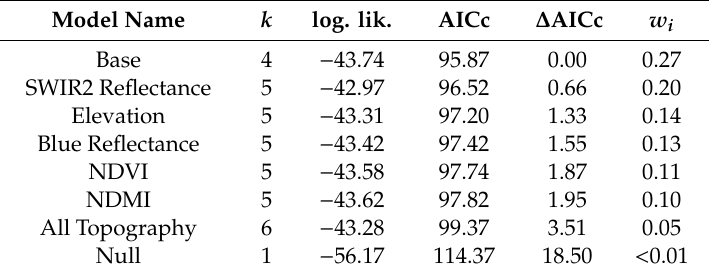
Table 4. Ranking of candidate models used to predict lichen presence as a function of forest structure, topographic and remote sensing attributes (Table 3). Models with a lower Akaike Information Criterion score (AIC c ) better describe the data. k = number of fixed e ff ects ( + 1 for intercept) and w i = Akaike weight. SWIR2 = short-wave infrared reflectance, NDVI = normalized di ff erence vegetation index, NDMI = normalized di ff erence moisture index (Appendix C).